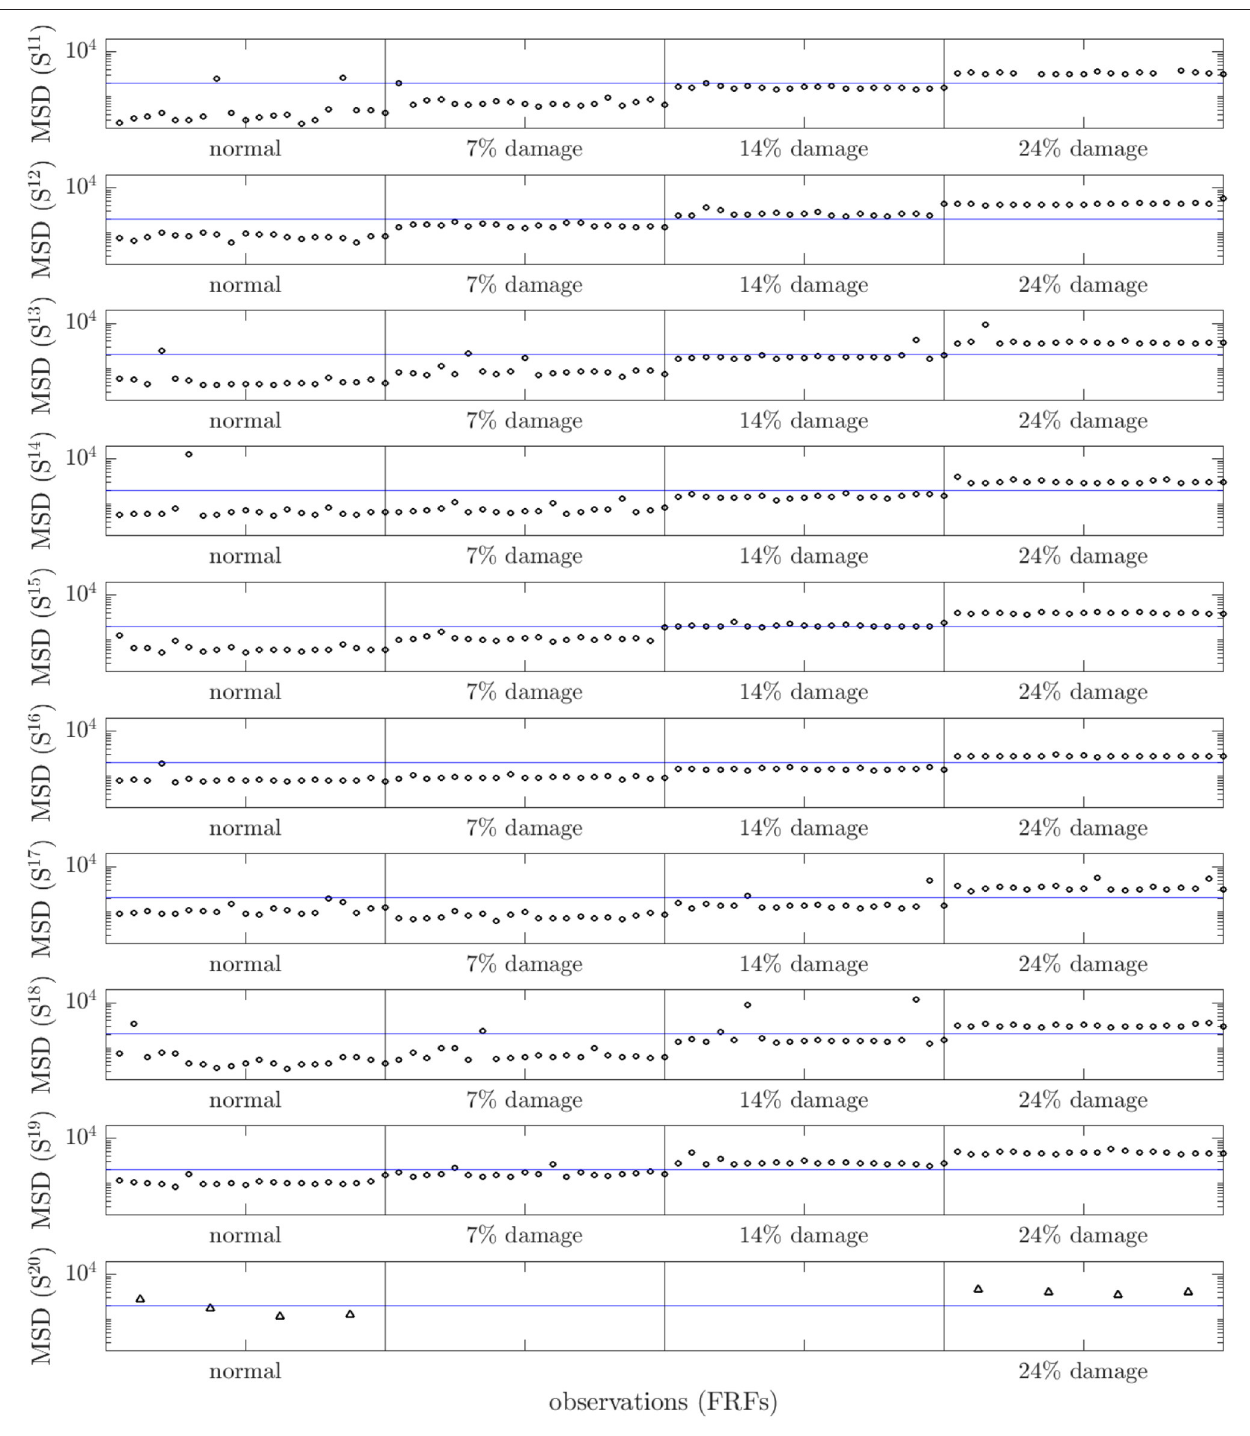
is assumed to capture the “essence” of the structure, while the predictive variance provides a characterization of the variability across the